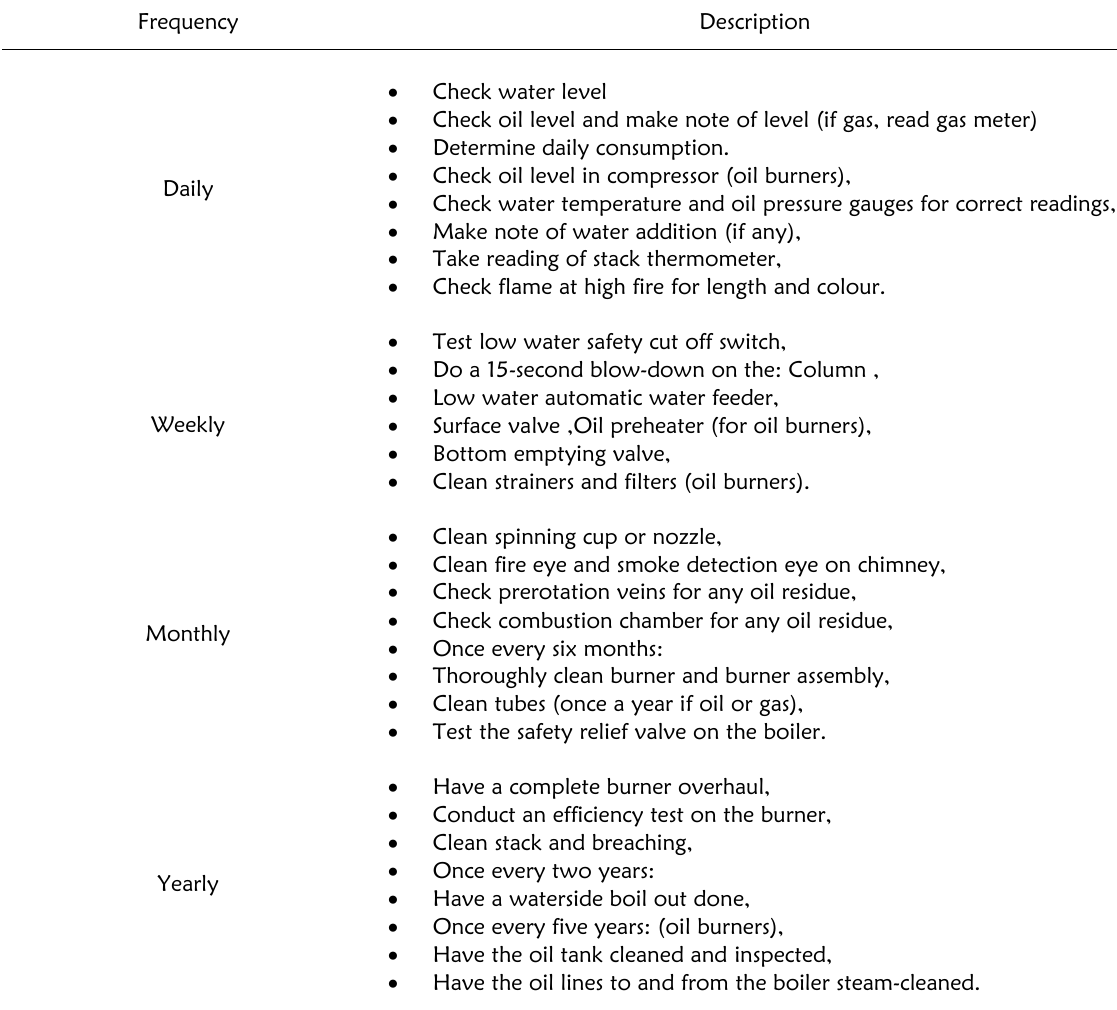
Table 1: Schedule of preventive maintenance of steam boiler (Mobley, 2002)